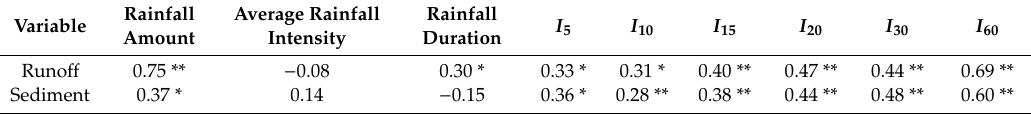
Table 4. Correlation of statistical characteristic indicators of rainfall with sediment yield and runo ff .